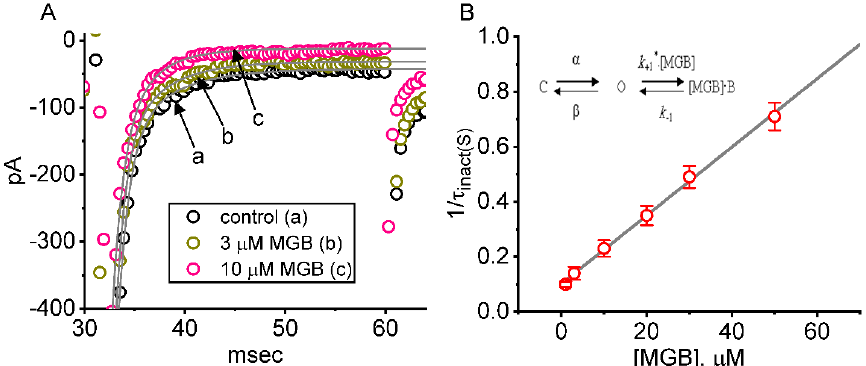
Figure 2. Kinetic assessment of MGB-induced block of I Na . ( A ) Inactivation time courses of I Na evoked by the depolarizing step from − 100 to − 10 mV for a duration of 30 ms. Each current trajectory in the absence (a), and the presence of 3 μ M MGB (b), or 10 μ M MGB (c) was well fitted with a least squares criterion by two-exponential decay, i.e., the sum of two exponentials (indicated by the gray smooth line). The values of the fast or slow component (i.e., τ inact(S) ) in the inactivation time constants of I Na(T) obtained in the control period and during exposure to 3 and 10 μ M MGB were 1.11, 0.098, and 0.091 ms (fast component), or 4.96, 4.13, and 3.31 ms (slow component), respectively. ( B ) Relationship of the MGB concentration as a function of the slow component in the inactivation rate constant (1/ τ inact(S) ) (mean ± SEM; n = 7 for each point). Of note, the value of 1/ τ inact(S) is linearly proportionally to the MBG concentration. Based on the heuristic minimal binding scheme (shown